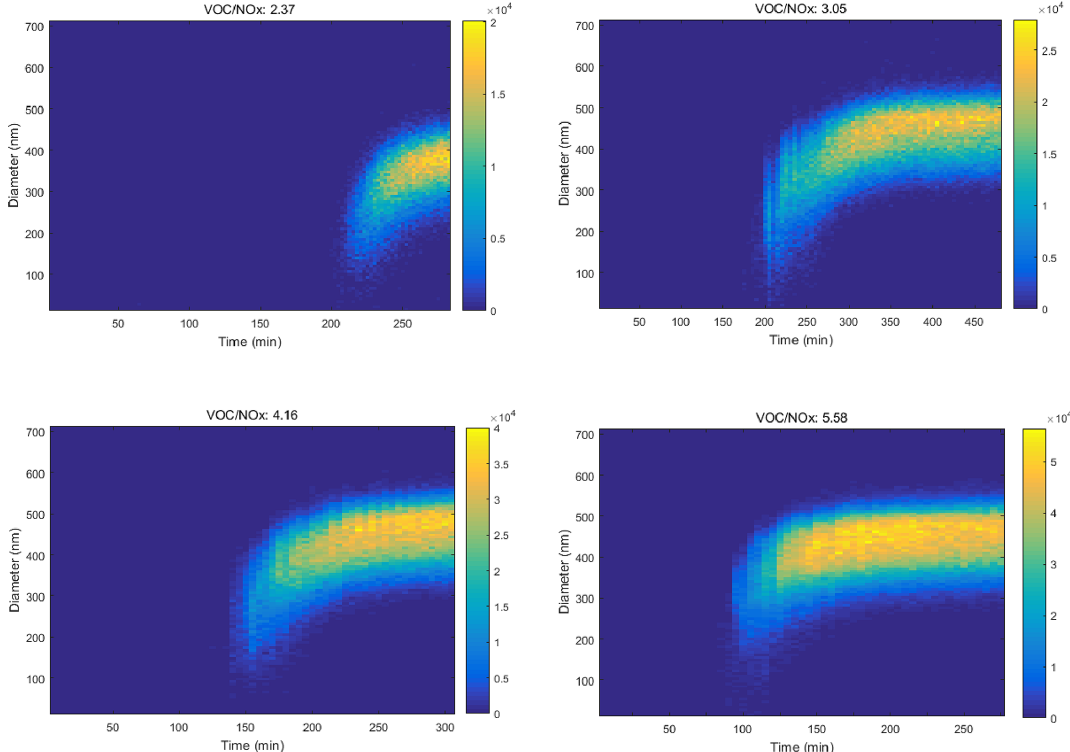
Figure 4. Nanoparticle distribution from toluene photochemical oxidation varied with time at different VOC / NO x ratios (the initial con- centrations of NO x were in the range of 158.2 to 179.7ppb).